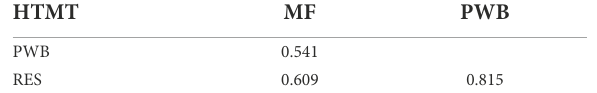
TABLE 3 Discriminant validity—Heterotrait-Monotrait ratio (HTMT).